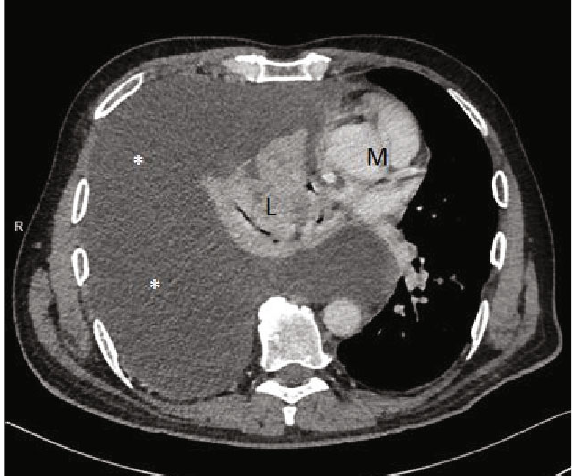
Figure 3: Computed tomography of chest cavity after intravenous contrast injection in axial plane. Free fl uid in the right pleurum with atelectasis of the right lung and mediastinal shift. ∗ Free fl uid in pleural cavity. L: lung; M: